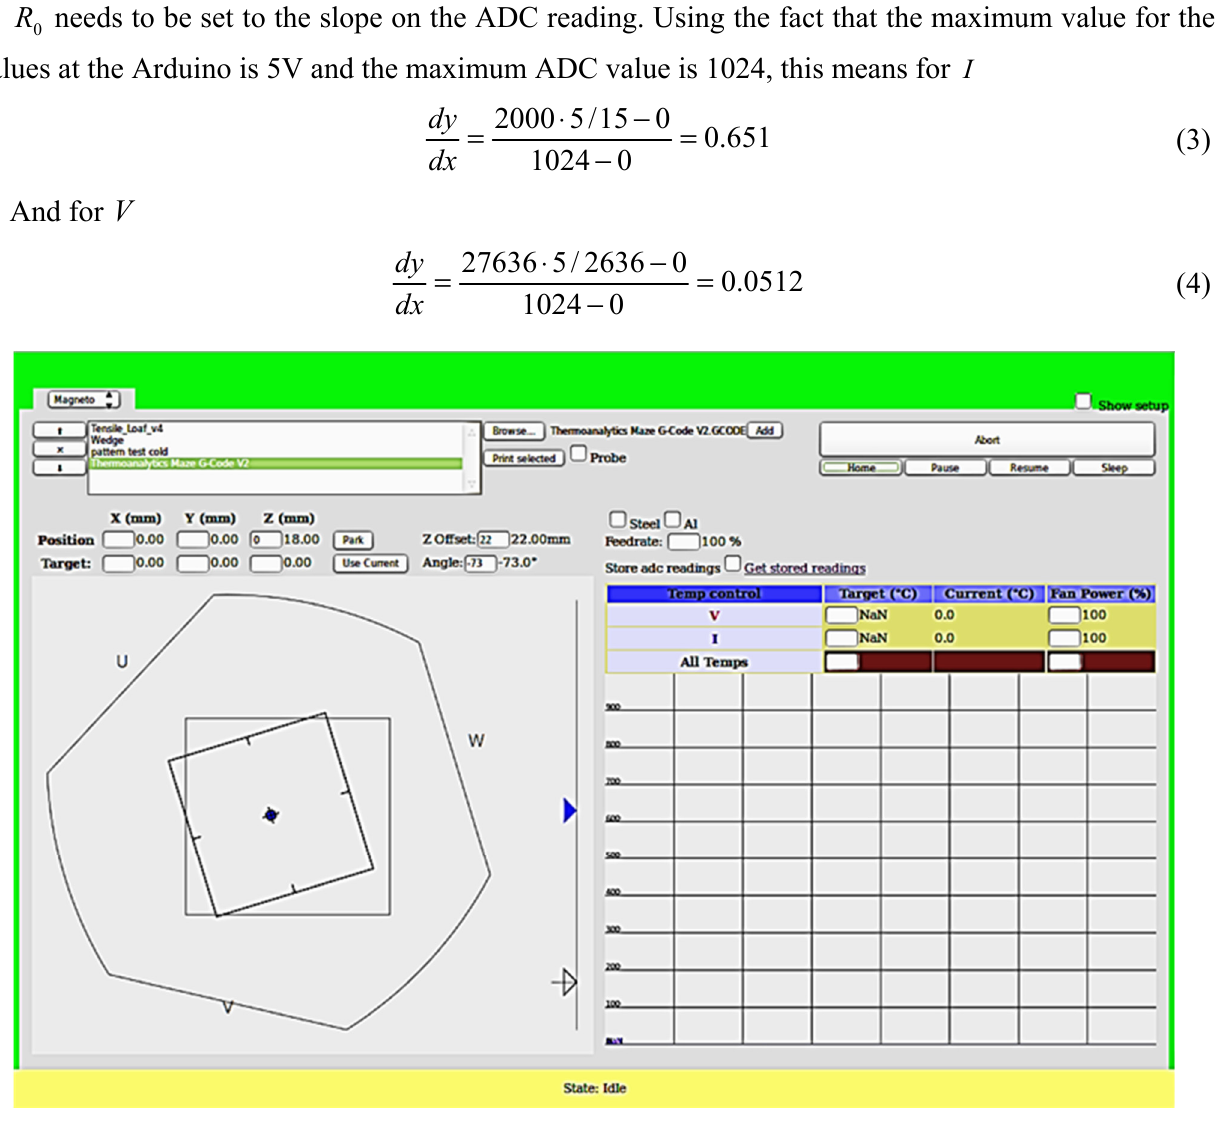
Figure 4. Screenshot of the interface for the open source Franklin